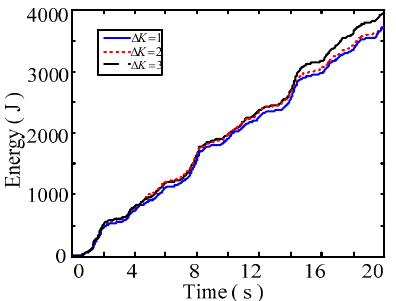
Figure 16. The curves of energy consumption for different step sizes.